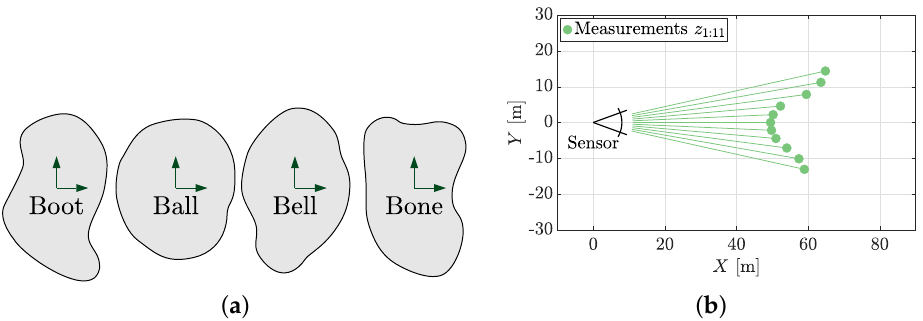
Figure 15. This problem seeks to establish which of four nugget geometries is most likely represented by the range measurements Z . ( a ) Four chicken nugget shapes. ( b ) A measurement set, Z = { z 1:11 } , is produced from the Bone nugget.